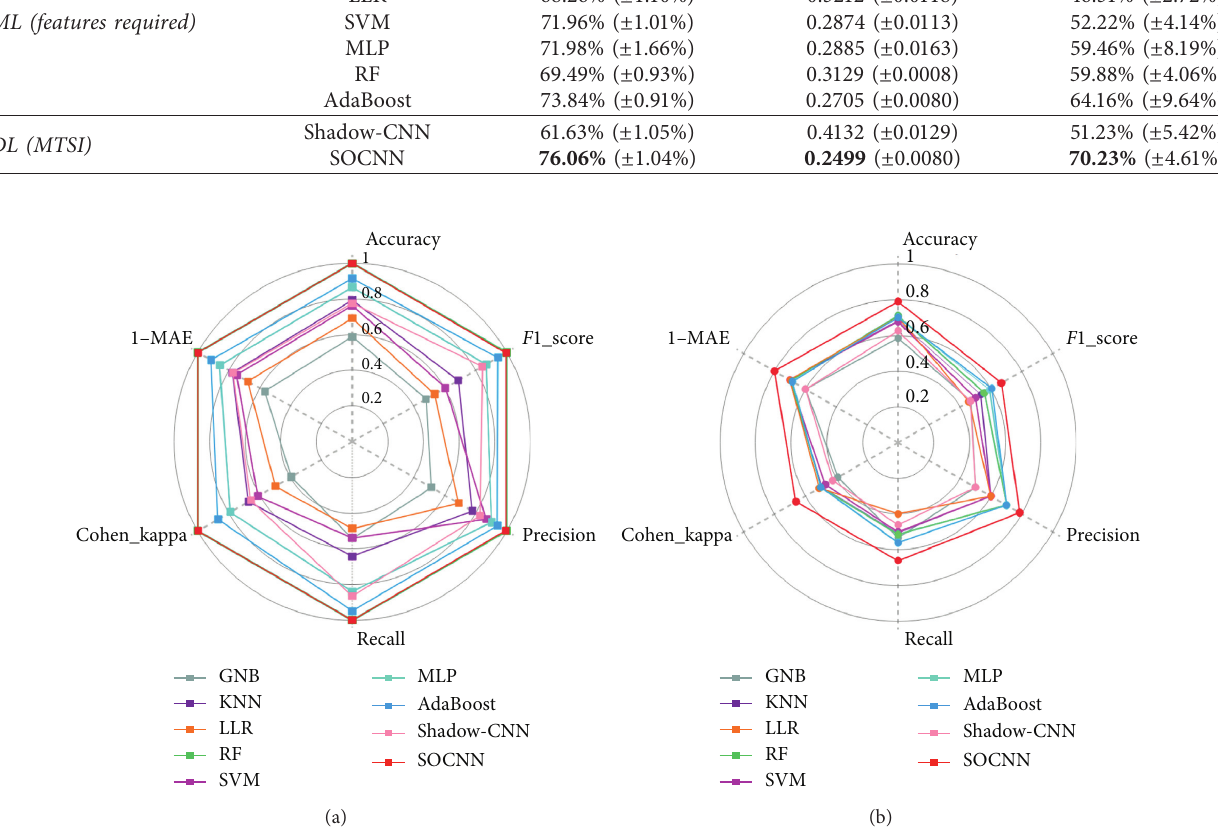
Figure 6: Rader chart of different metrics: (a) training set; (b) test